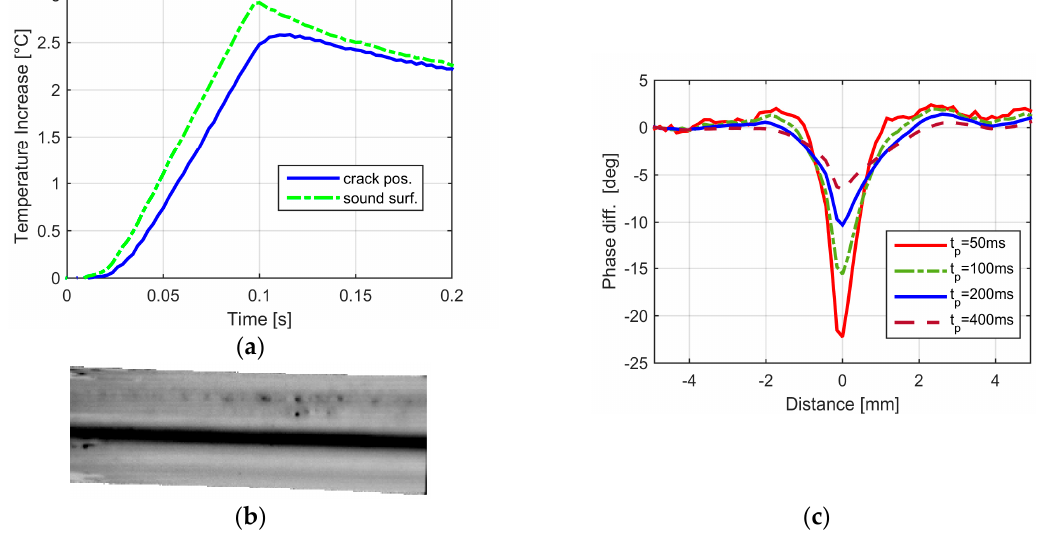
Figure 27. Results for a titanium wire with a rolling lap. ( a ) temperature curves; ( b ) phase image with a 0.1 s heating pulse; ( c ) phase profiles with different pulse lengths.